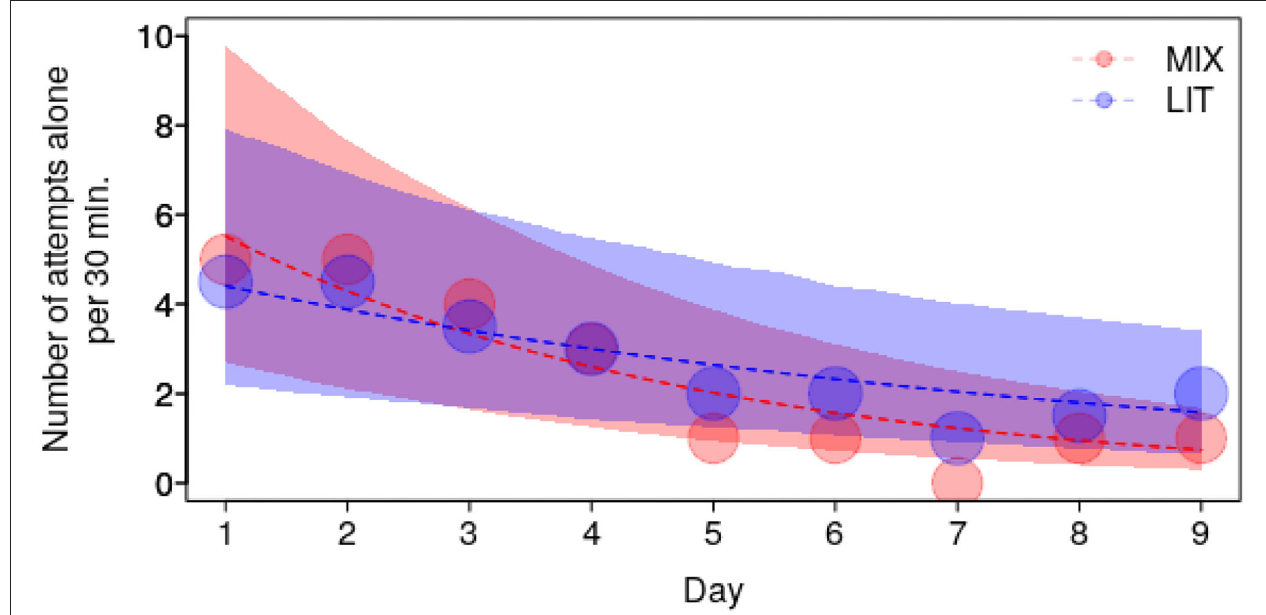
FIGURE 5 | Frequency of Attempts alone as a function of test day, for the two group compositions with mixed groups in light red (MIX) and littermate groups (LIT) in dark blue. Dots show the median number of Attempts Alone per test day whereby the area of the dots depicts the number of counts (range: 43 to 48). The dashed lines and the shaded polygons depict the fitted model and its confidence